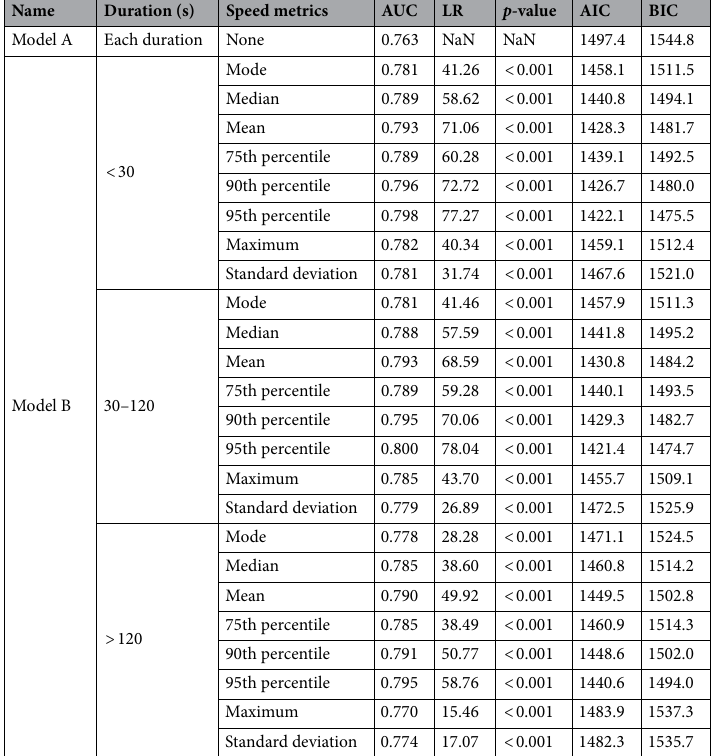
Table 2. Effect of adding the speed metrics to predict frailty status, CoLaus cohort, Lausanne, Switzerland, 2014–2017. Model A includes gender, age, BMI, and PA; model B consists of all variables from model A plus the variable of interest (the speed metric specified in each row). Models A and B were compared by likelihood ratio (LR) test. GB gait bout, NaN the values which were not possible to be computed, AUC area under the ROC curve, AIC Akaike’s information criterion, BIC Bayesian information